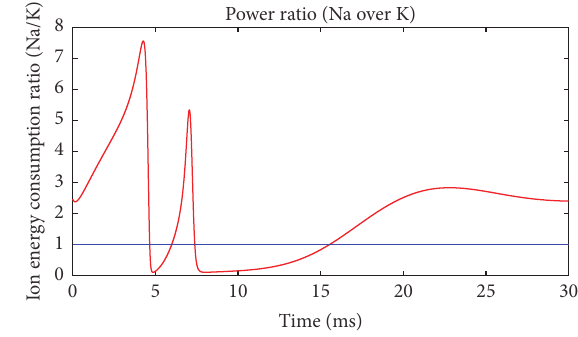
Figure 4: Net current (suprathreshold).